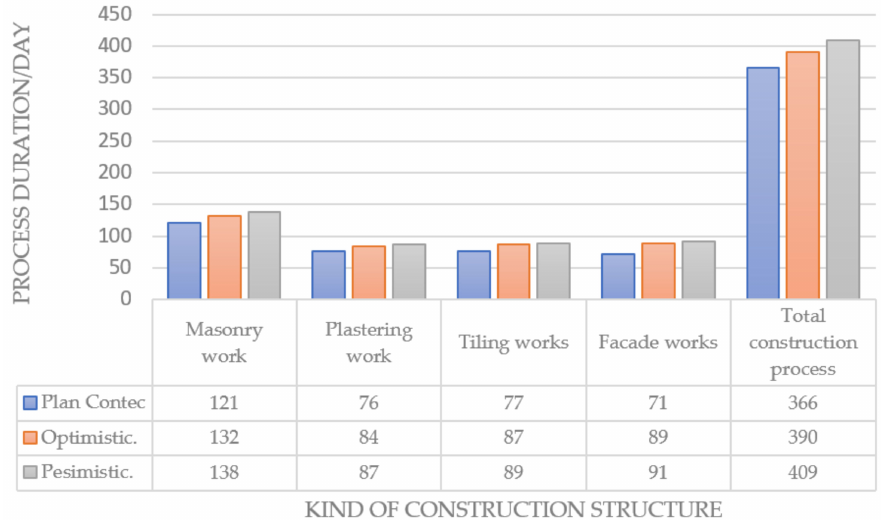
Figure 17. Duration of construction processes.